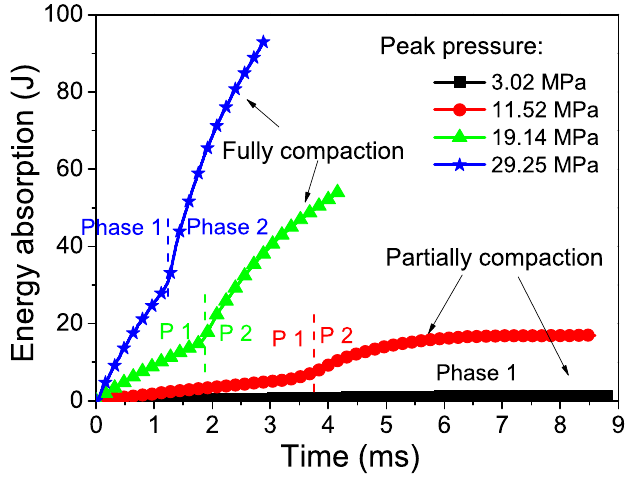
Figure 10. Energy absorption of two-layer graded foam under different blast pressures. g = 0.3.